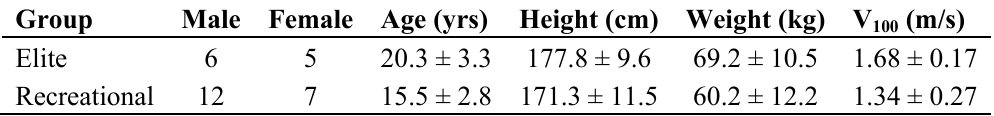
Table 1. Statistics of the measurement population. All variables are presented as mean ± standard deviation. V shows the average of best personal 100 m 100